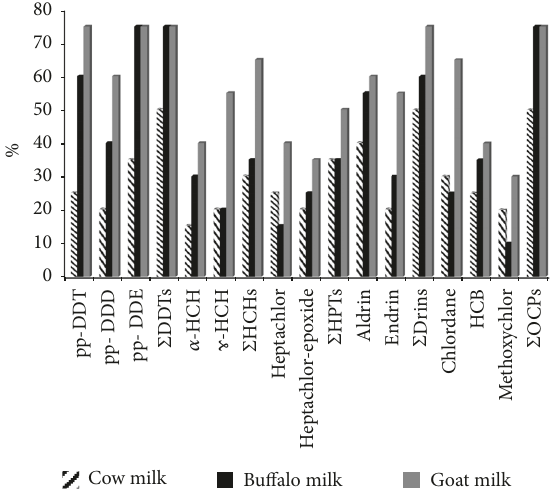
Figure 1: Frequency (%) of individual and total OCPs contamina- tion of the examined milk samples from different animal species (n=20 each).